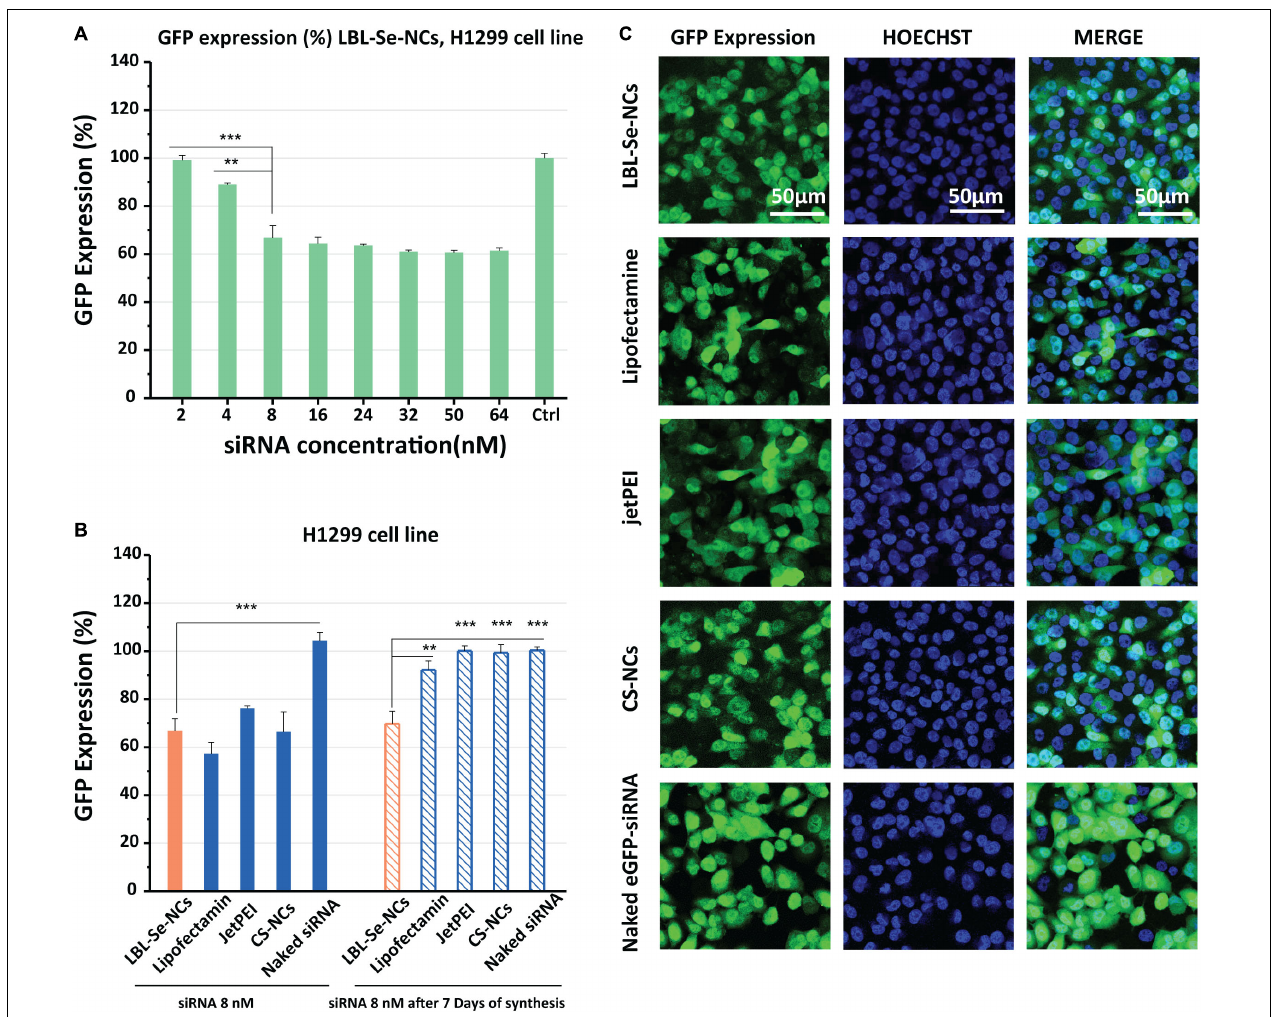
FIGURE 4 | In vitro knockdown efficiency of LBL-Se-NCs. (A) GFP expression (%) of H1299 cells treated with LBL-Se-NCs as a function of siRNA concentration. (B) Comparison of the GFP expression level on H1299 cells after treatment with LBL-Se-NCs, Lipofectamine, jetPEI, CS-NCs, and naked siRNA, all at 8 nM effective siRNA concentration, for both freshly synthesized and 7-day-old nanocomplexes . (C) Confocal images of intracellular GFP knockdown of LBL-Se-NCs and control groups on H1299 cells. The scale bar corresponds to 50 µ m. Data are presented as mean values ± SD ( n = 3, * p < 0.05; ** p < 0.01; *** p <